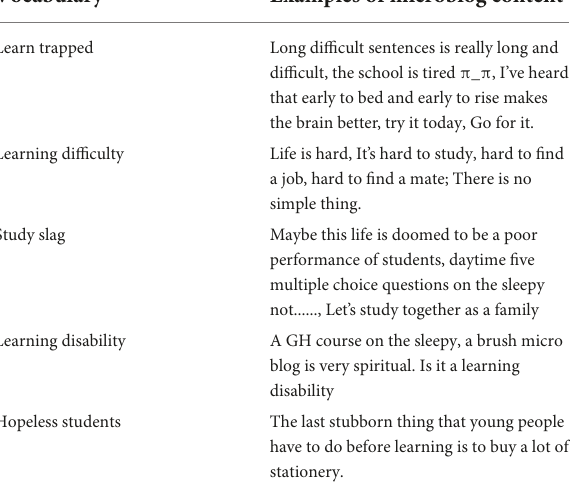
TABLE 2 Words and examples corresponding to stress events of learning